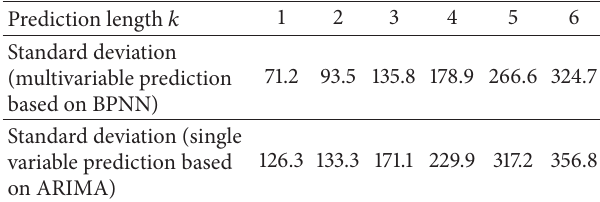
Figure 7: Results of prediction in different icing process ( 𝑘 = 1 ). Table 4: The error variances of icing load prediction in different icing